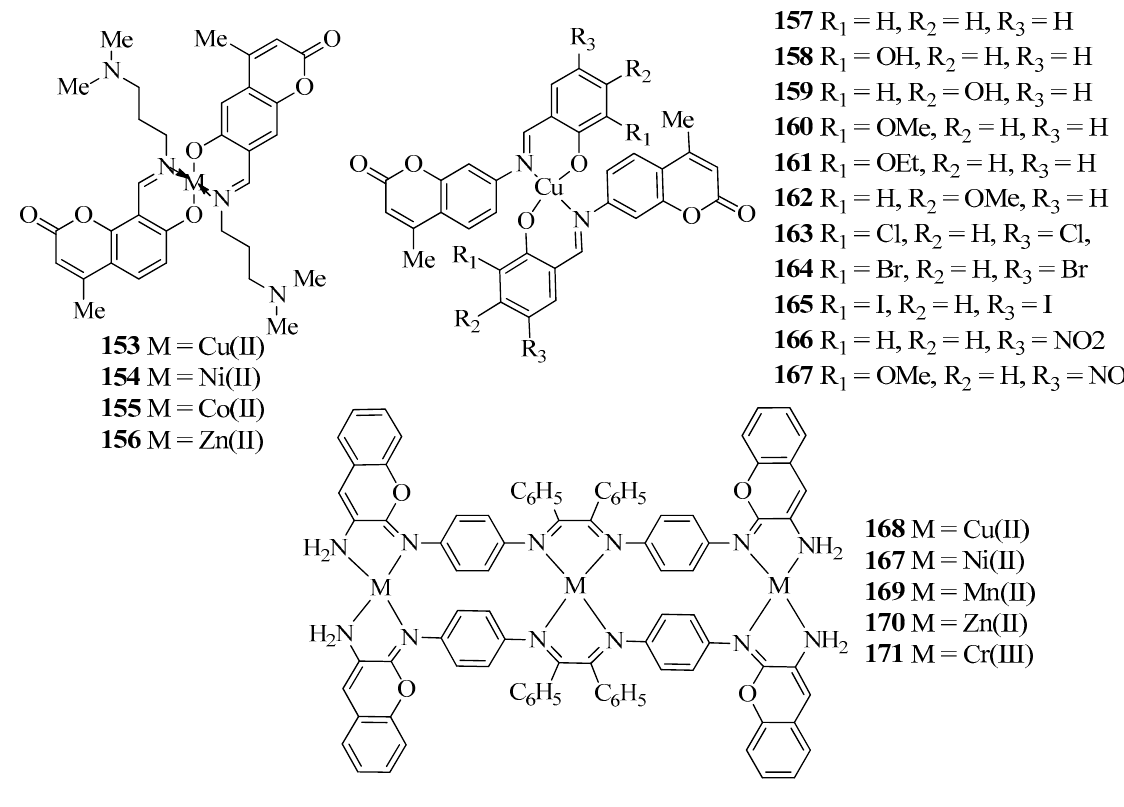
Figure 6. Structures of coumarin-derived imine–metal complexes ( 153 – 171 ).